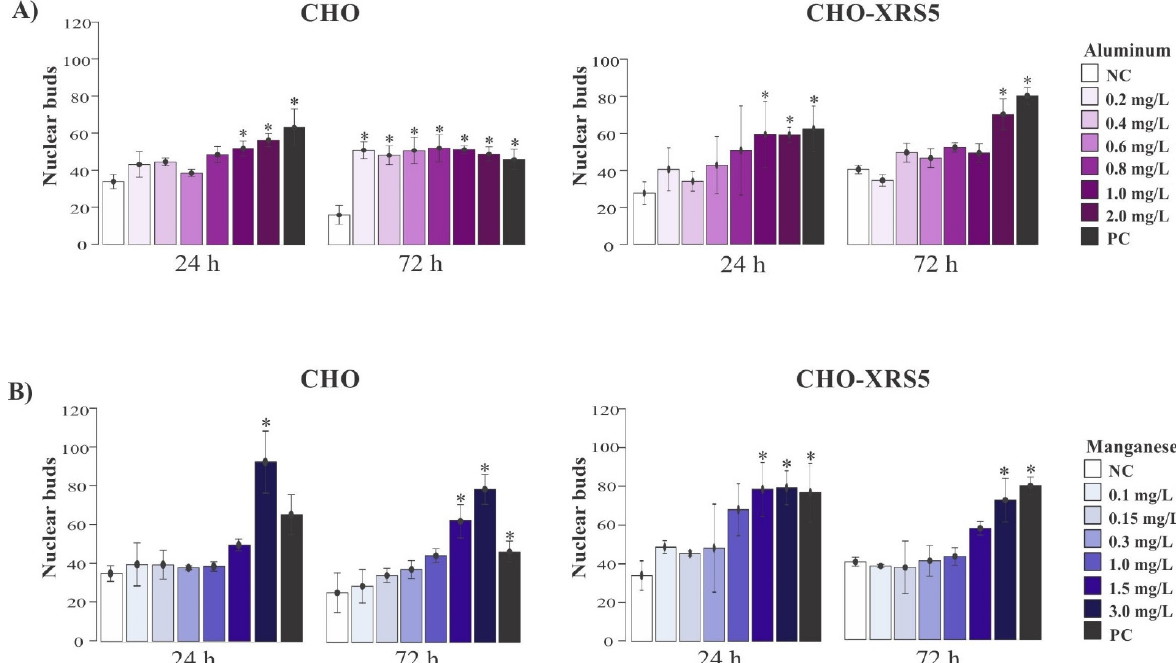
Figure 2. Effect of aluminum ( A ) and manganese ( B ) on nuclear bud formation in binucleated Chinese hamster ovary (CHO) and CHO-XRS5 cells after 24 and 72 h of incubation. Data are expressed as means ± standard deviation of two independent experiments. * p < 0.05 compared to the negative control via analysis of variance followed by Tukey’s test. NC, negative control; PC, positive control.